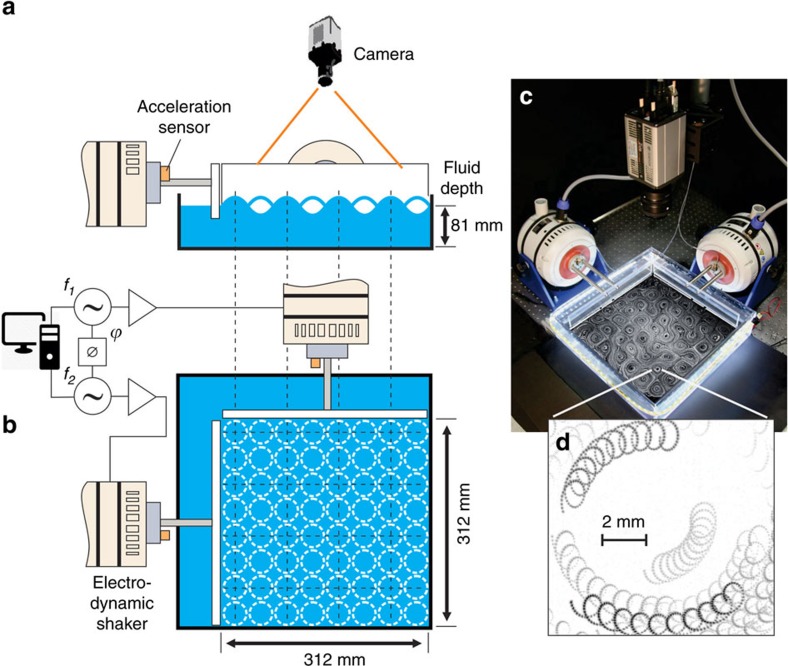
Experimental set-up.(a,b) Schematics of the experimental set-up for the controlled superposition of two orthogonal standing waves in a fluid tank. Waves are created using two computer controlled electrodynamic shakers. The amplitudes, frequencies and relative phase of the two waves are adjusted with high accuracy. Both the wave field and the surface flow can be measured (see ‘Methods' section for details). (c) A photo of the laboratory set-up showing the time-averaged streaks of drifting imaging particles. (d) Zoom into spatially resolved, small-scale particle drifting orbits.